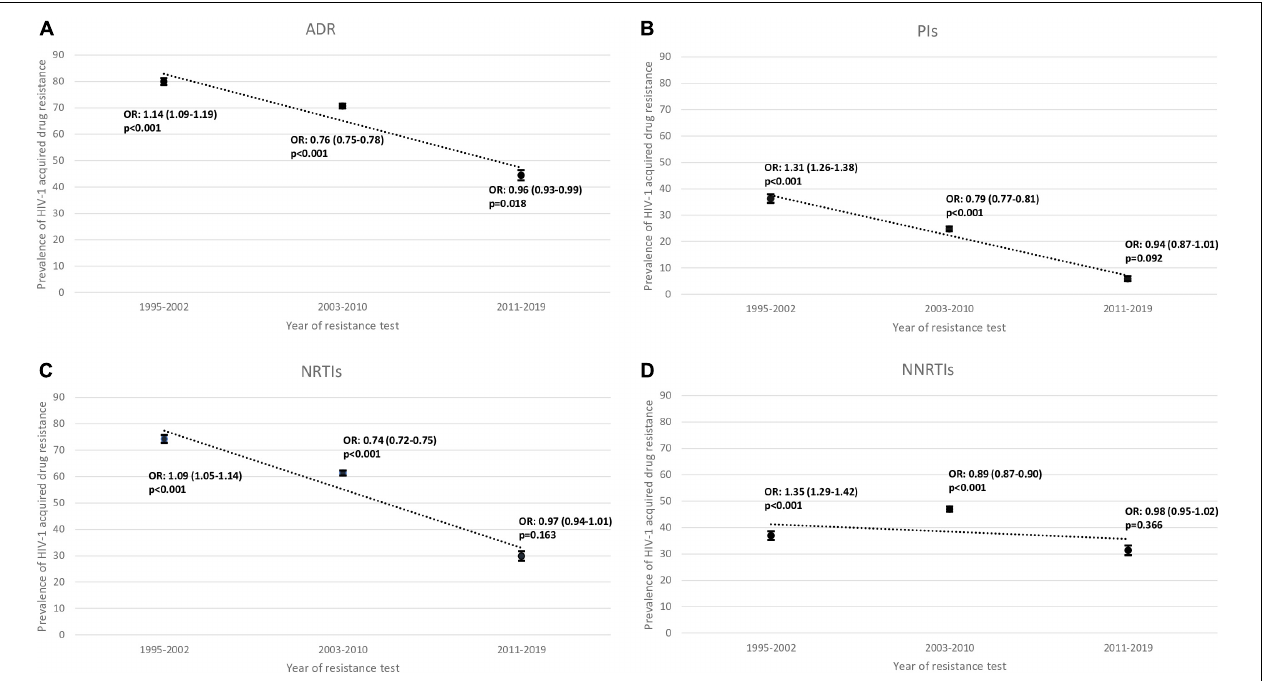
FIGURE 2 | Proportion of (A) overall acquired drug resistance (ADR), (B) of protease inhibitors (PIs), (C) of nucleoside reverse transcriptase inhibitor (NRTIs) and (D) of non-nucleoside reverse transcriptase inhibitor (NNRTIs) in sequences from drug-experienced patients between three periods 1995–2002, 2003–2010 and 2011–2019. OR, Odds Ratio; p , p -value.